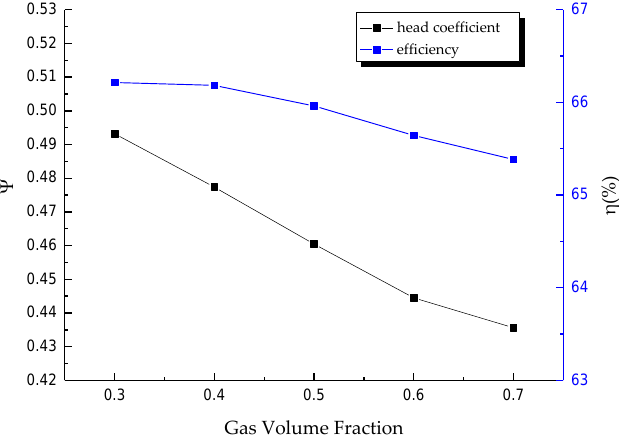
Figure 6. Hydraulic performance of a multiphase pump with different inlet gas volume fractions.